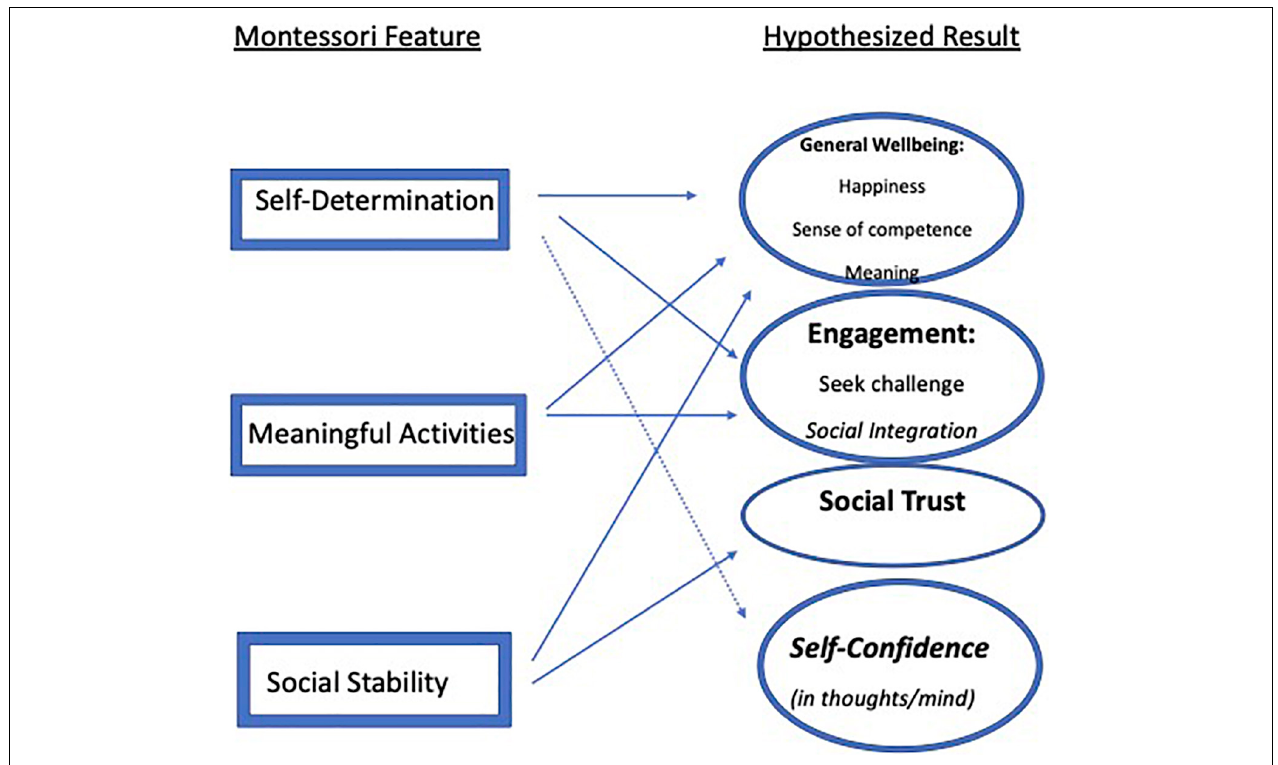
FIGURE 1 | Final model of hypothesized relation of Montessori features to wellbeing aspects. This is the final model that was arrived at after analyses; the hypothesized model described in the text has a different set of hypothesized results.